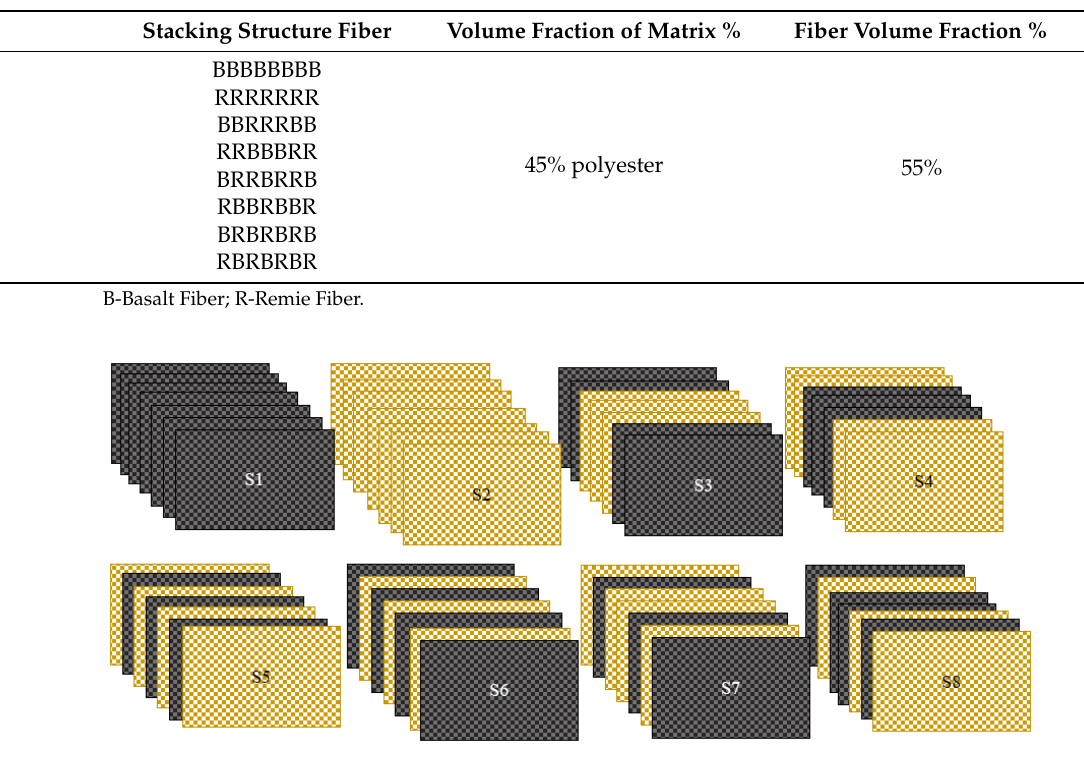
Figure 2. Stacking sequence of composite laminates. (S1-BBBBBBBB; S2-RRRRRRR; S3-BBRRRBB;